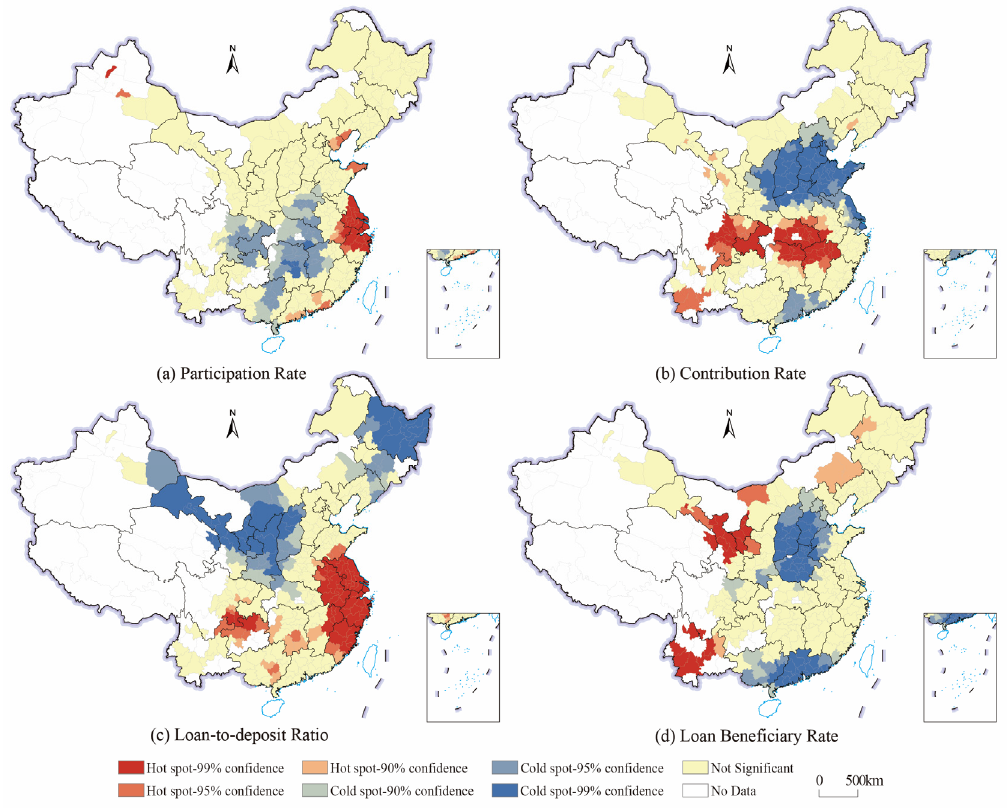
Figure 2. The hotspots map of the HPF equity performance from 2015 to 2020. Note: Based on the average value of cities from 2015 to 2020, the hotspots map was drawn using ArcGIS software.